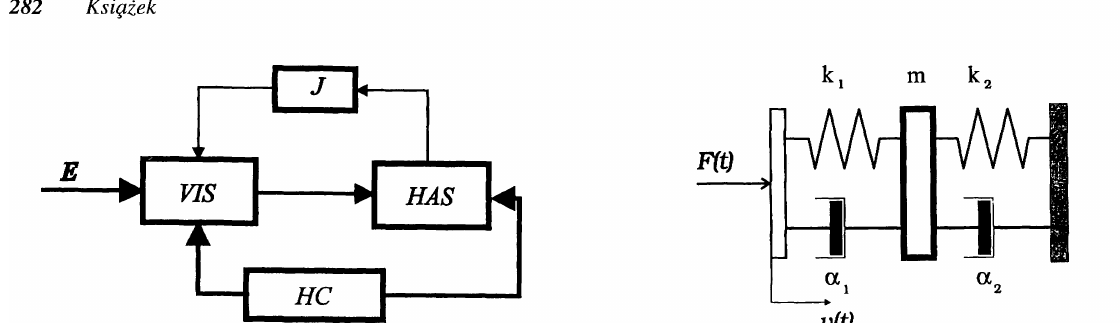
FIGURE 1 Principal factors of the problem of the vibra tion isolation of hand-arm and whole body systems: E, exci tation; VIS, vibration isolation system; HAS, hand-arm sys tem; He, human controller; and J, criterion of isolation.